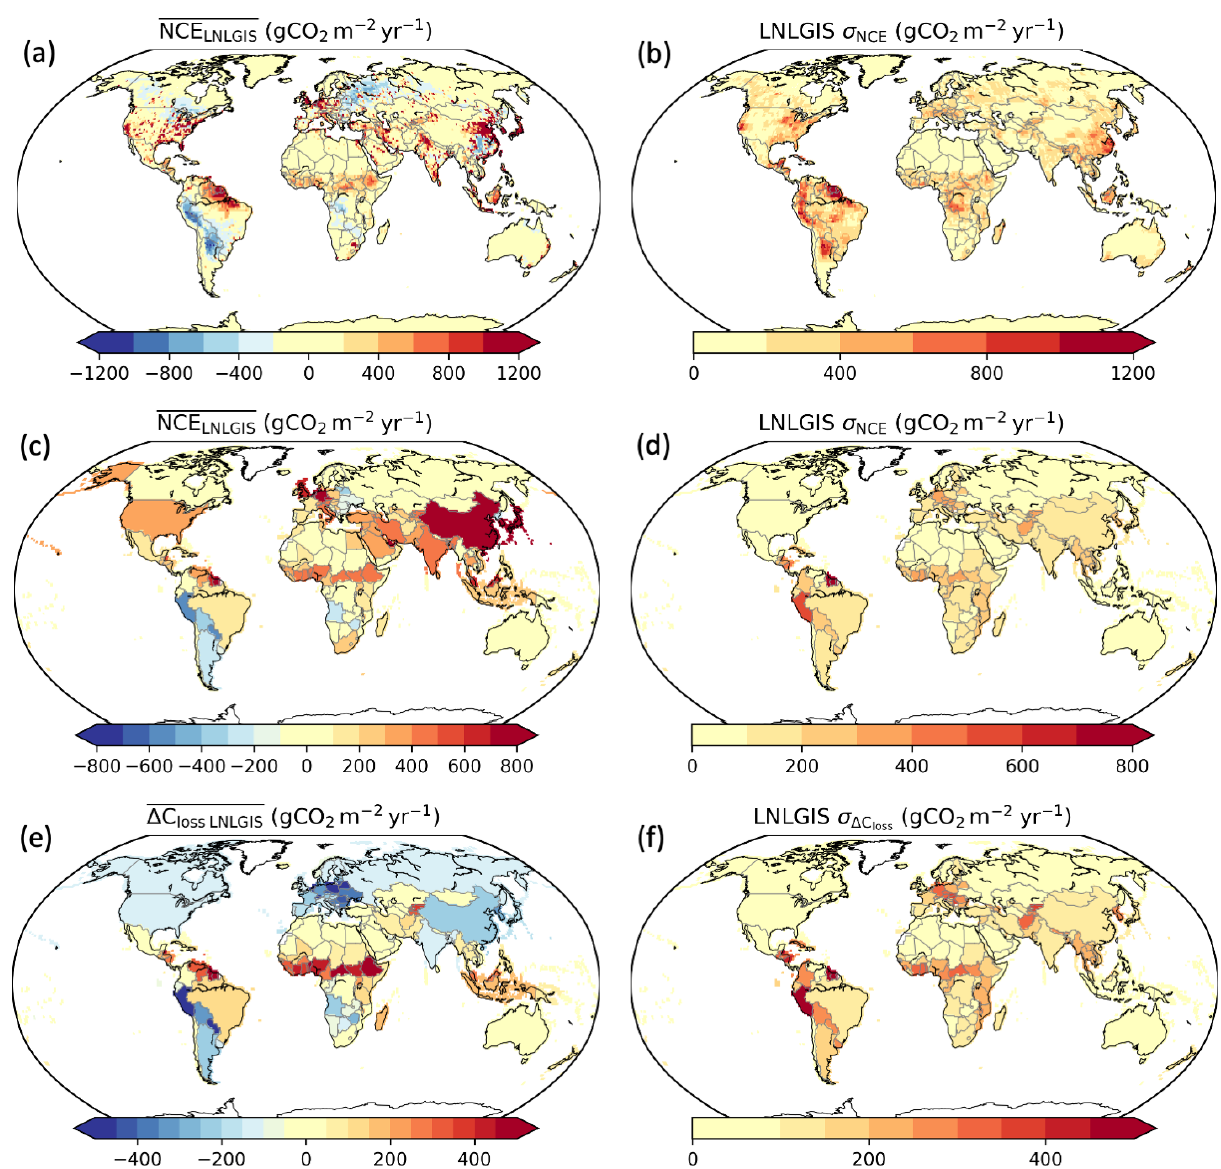
Figure 12. Median (NCE) and 1 standard deviation ( σ NCE ) of NCE on a (a, b) 1 ◦ × 1 ◦ grid and (c, d) aggregated to country scale for the v10 OCO-2 MIP LNLGIS experiment averaged over 2015–2020. (e, f) Median and 1 standard deviation of country-scale (cid:49)C loss averaged over 2015–2020 derived from the LNLGIS v10 OCO-2 MIP